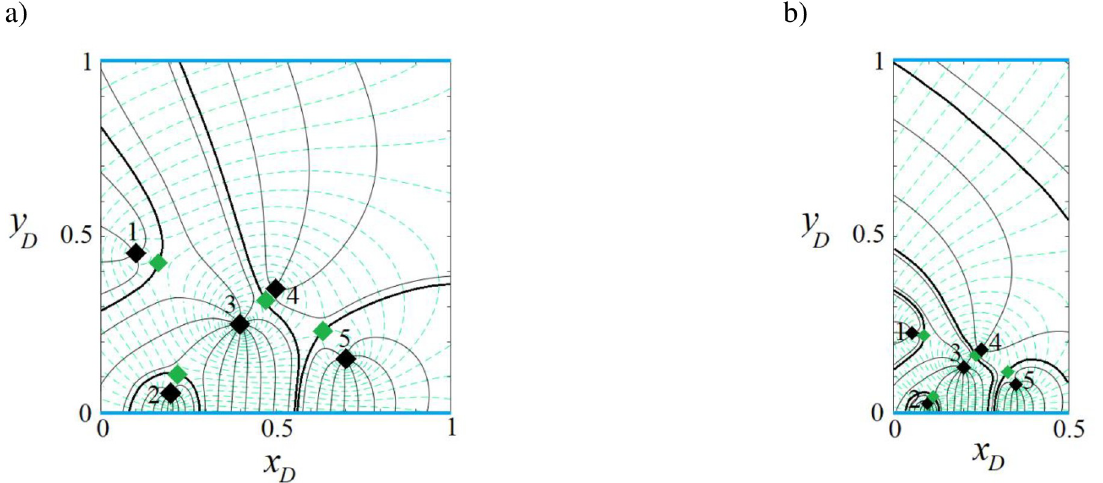
Fig 10. Velocity potential and streamlines when the well distances to the north boundary increased by (a) 2 and (b) 4 times, respectively compared to Fig 4D.